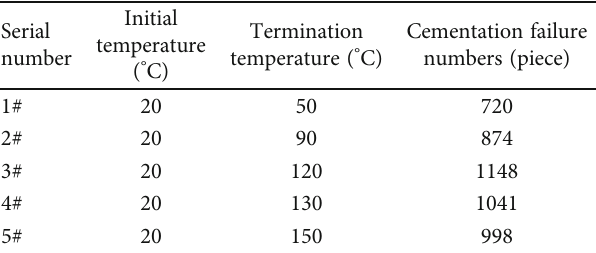
Table 4: Cementation failure number of sample model at di ff erent temperatures.